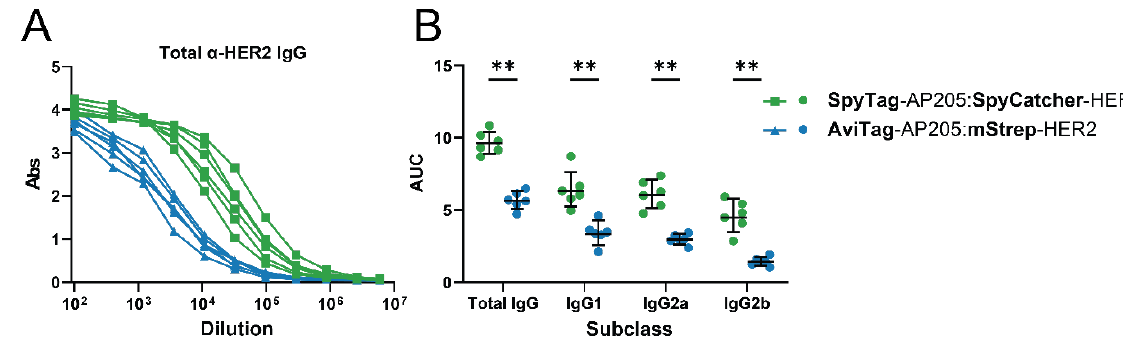
Figure 4. Effect of conjugation system on IgG profile. Mice ( n = 6) were immunized with 2 µg HER2 coupled to AP205 cVLPs using either a covalent (SpyTag/SpyCatcher) or affinity-based (AviTag/mStrep) conjugation system. HER2-specific antibodies were quantified by ELISA. ( A ) Total IgG dilution curves and ( B ) AUC for total IgG, IgG1, IgG2a and IgG2b. Each dot represents one animal. Full dilution curves are available in Supplementary Figure S2. ** p <